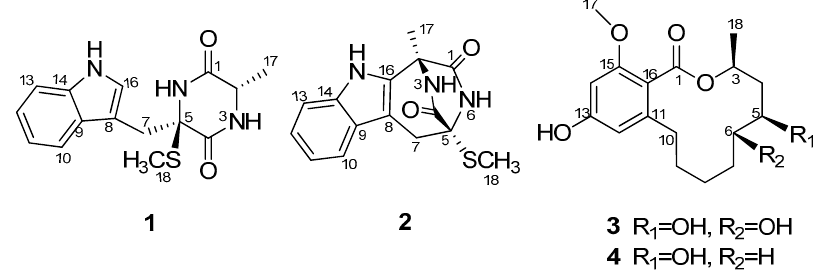
Figure 1. Chemical structures of compounds 1 – 4 .